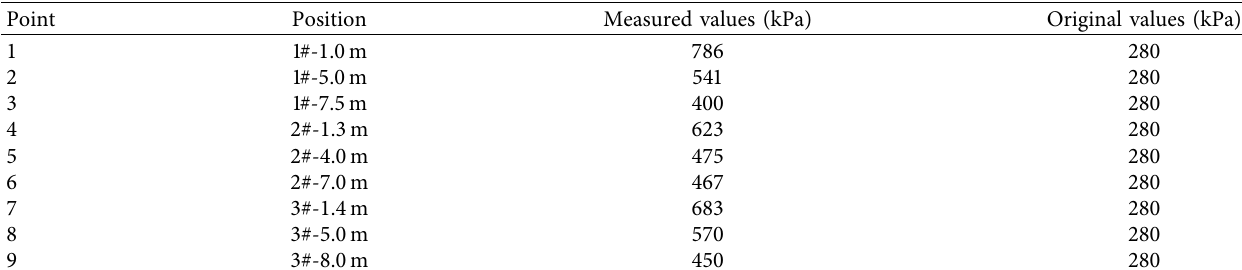
Table 6: Super heavy dynamic penetration N120 detection bearing capacity characteristic